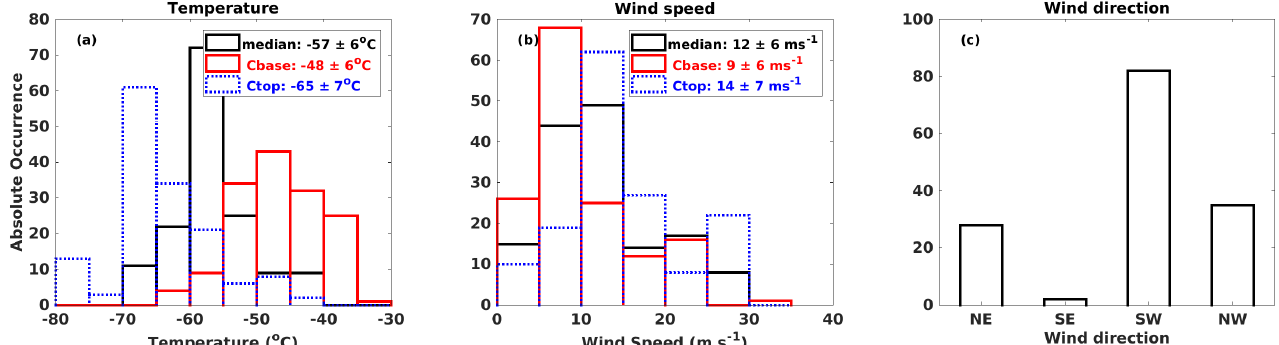
Figure 5. Absolute occurrence distribution of temperature ( a ), wind speed ( b ) and wind direction ( c ) within the cirrus layer altitude range, presented as layer median, at the C base and at the C top . The median ± standard deviation is given in the legend. Only observations satisfying the 2 h temporal criterion are